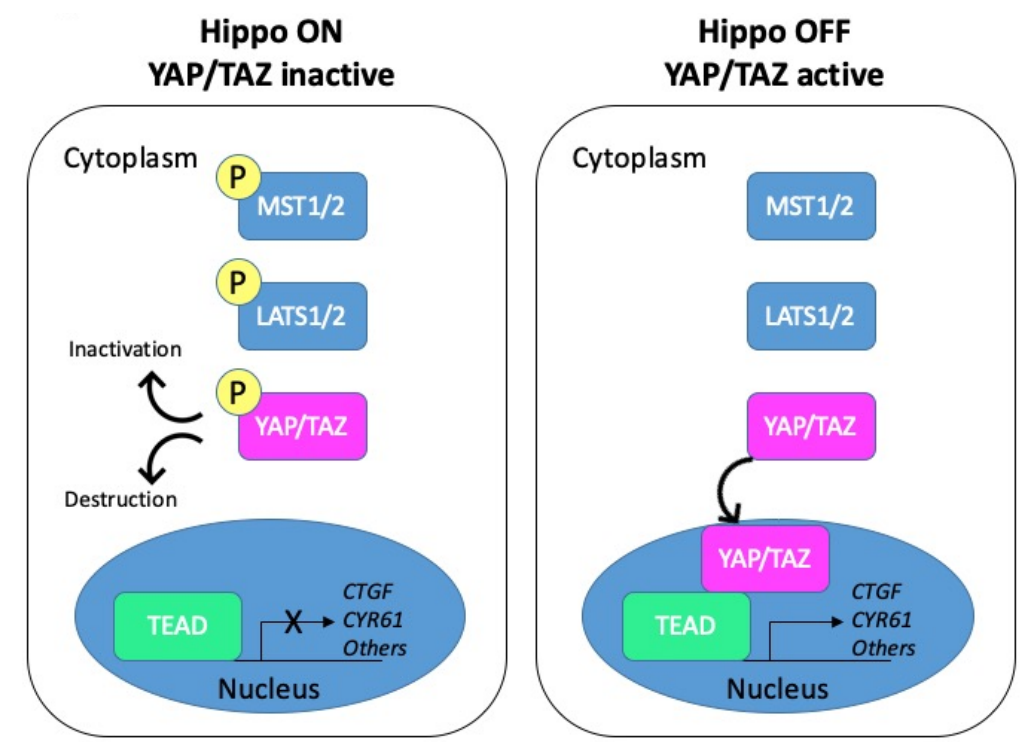
Figure 2. Schematic representation of the Hippo pathway. Left panel: when the Hippo pathway is on, the core kinases MST1/2 are phosphorylated and in turn phosphorylate the LATS1/2 kinases. Activated LATS1/2 phosphorylate YAP/TAZ, which promotes their cytoplasmic retention through binding to 14-3-3 proteins or their degradation. YAP/TAZ are thus inactive. Right panel: when the Hippo pathway is off, YAP/TAZ are dephosphorylated and can shuttle to the nucleus. Active YAP/TAZ bind transcriptional factors and induce the transcription of target genes such as CTGF or CYR61 .